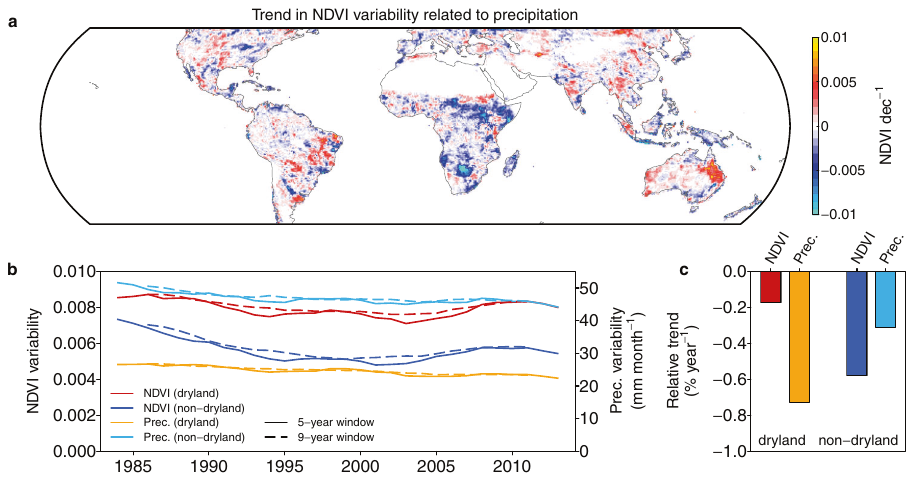
and precipitation variability for drylands and non-drylands. Dashed and solid lines indicatetimeseriesestimatedfromamovingwindowof108and60months(9and 5 years), respectively. c Normalized trend in σ NDVI prec (NDVI) and precipitation variability (Prec.) for dryland and non-dryland.